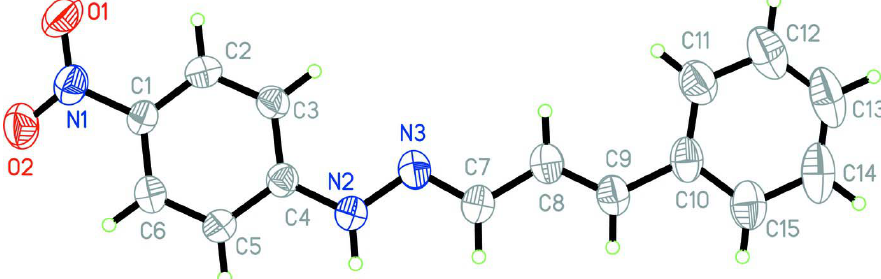
the ORTEP plot of (I). Displacement ellipsoids are drawn at the 30% probability level. H atoms are presented as small spheres of arbitrary